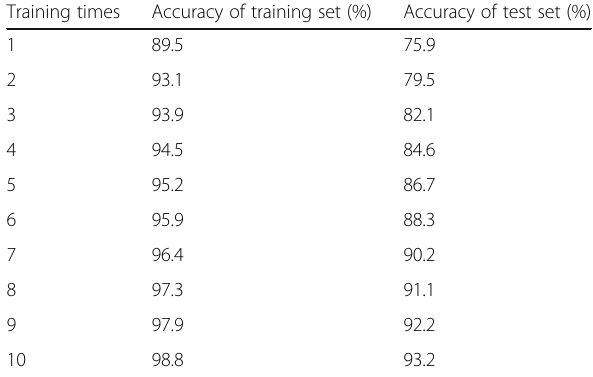
Table 3 Classification results of mixed models Training times